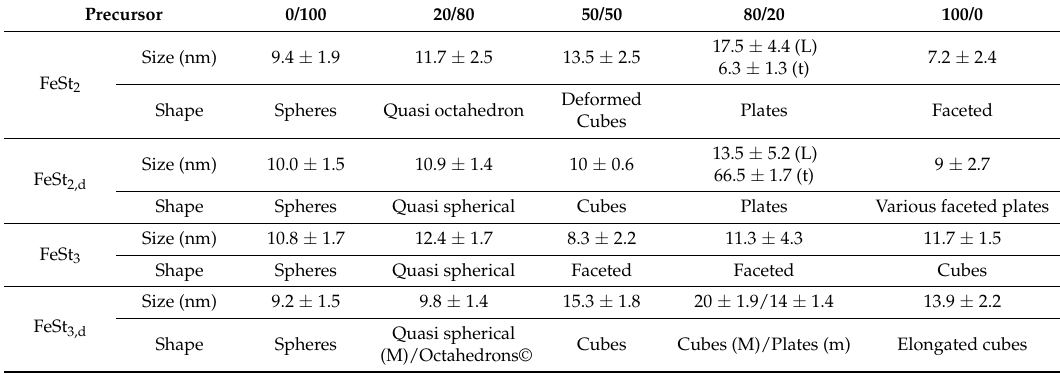
Figure 1. Influence of the ratio NaOl/OA on the shape of the nanoparticles (NPs) depending on the precursor structure and hydration degree. Table 2. Size and shape of nanoparticles as a function of the nature and amount of reactants (M: Majority, m: minatory, r: rare).